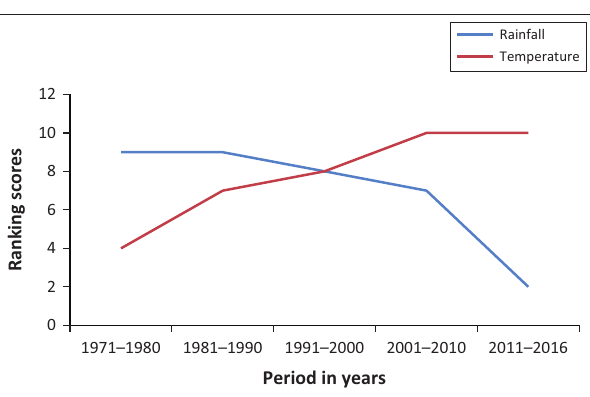
FIGURE 2: Community-perceived rainfall and temperature trends from the 10- year periods of 1971–1980 to